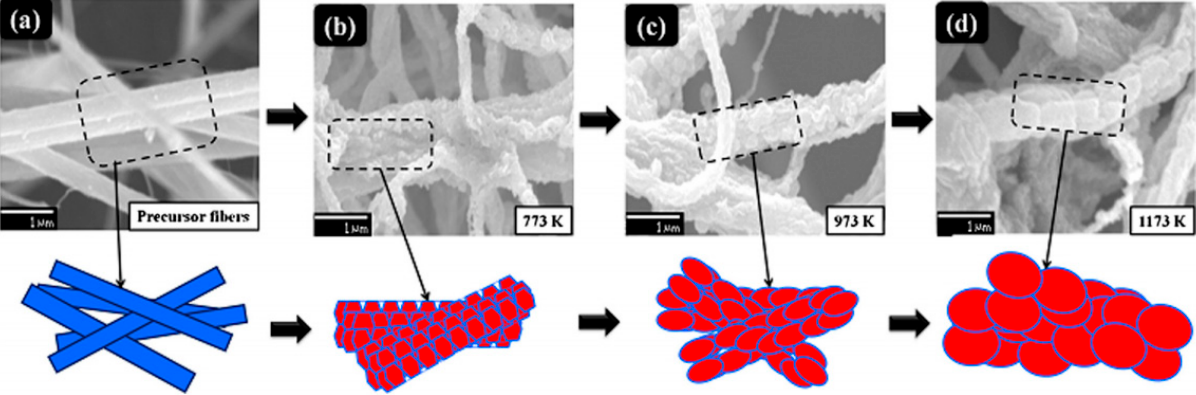
Figure 7. ( a ) SEM image of the composite precursor fiber (poly(styrene-co-acrylonitrile)-Zinc acetate dihydrate) and ( b – d ) schematic illustrations of the grain-growth mechanisms in ZnO nanofibers after calcination at T = 500, 700, and 900 °C. Reprinted with permission from [97]. Copyright 2014 Elsevier.